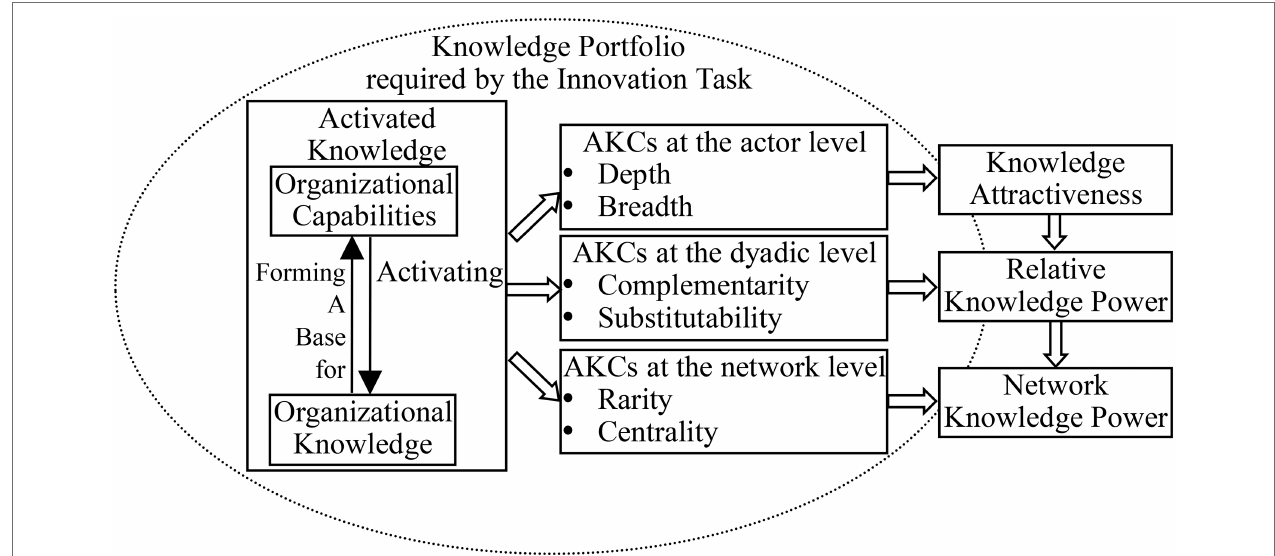
FIGURE 3 | Knowledge power in the innovation